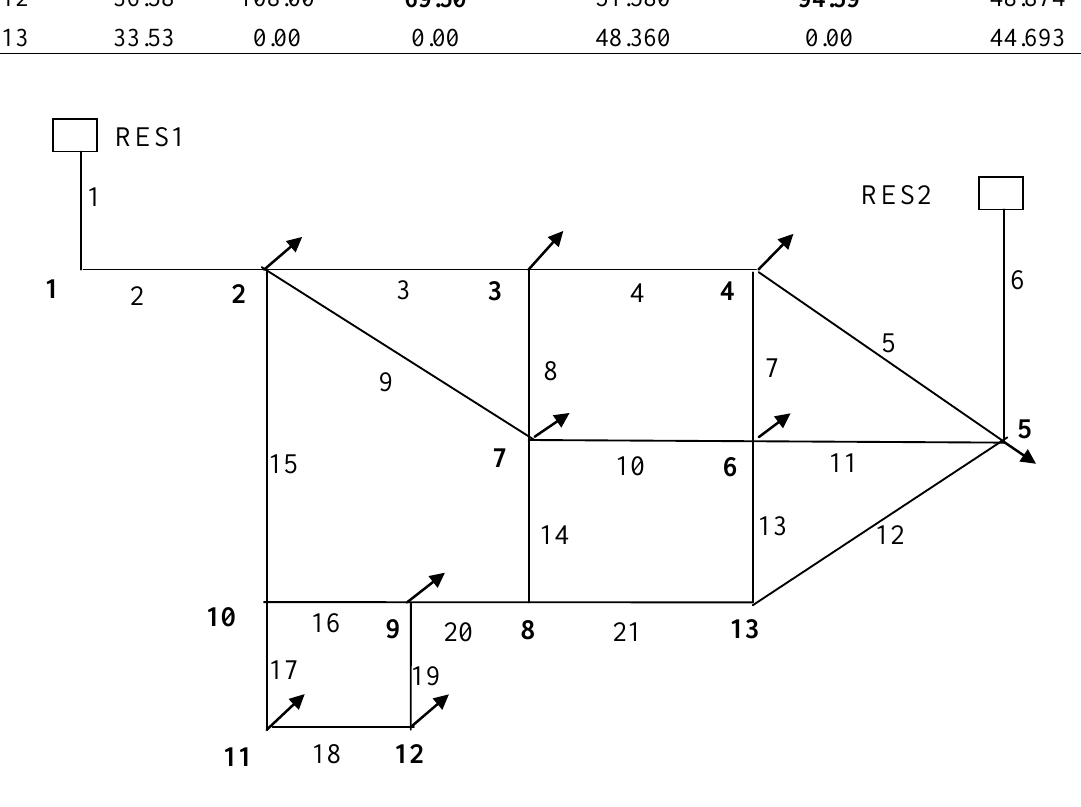
Fig. 7. Network for illustrative example